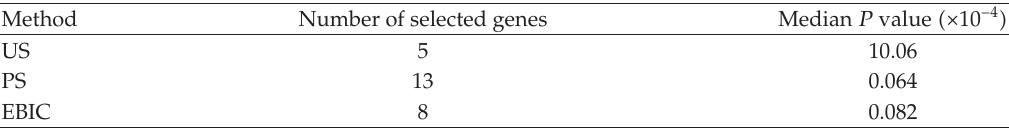
Table 2: Results for the microarray lung cancer